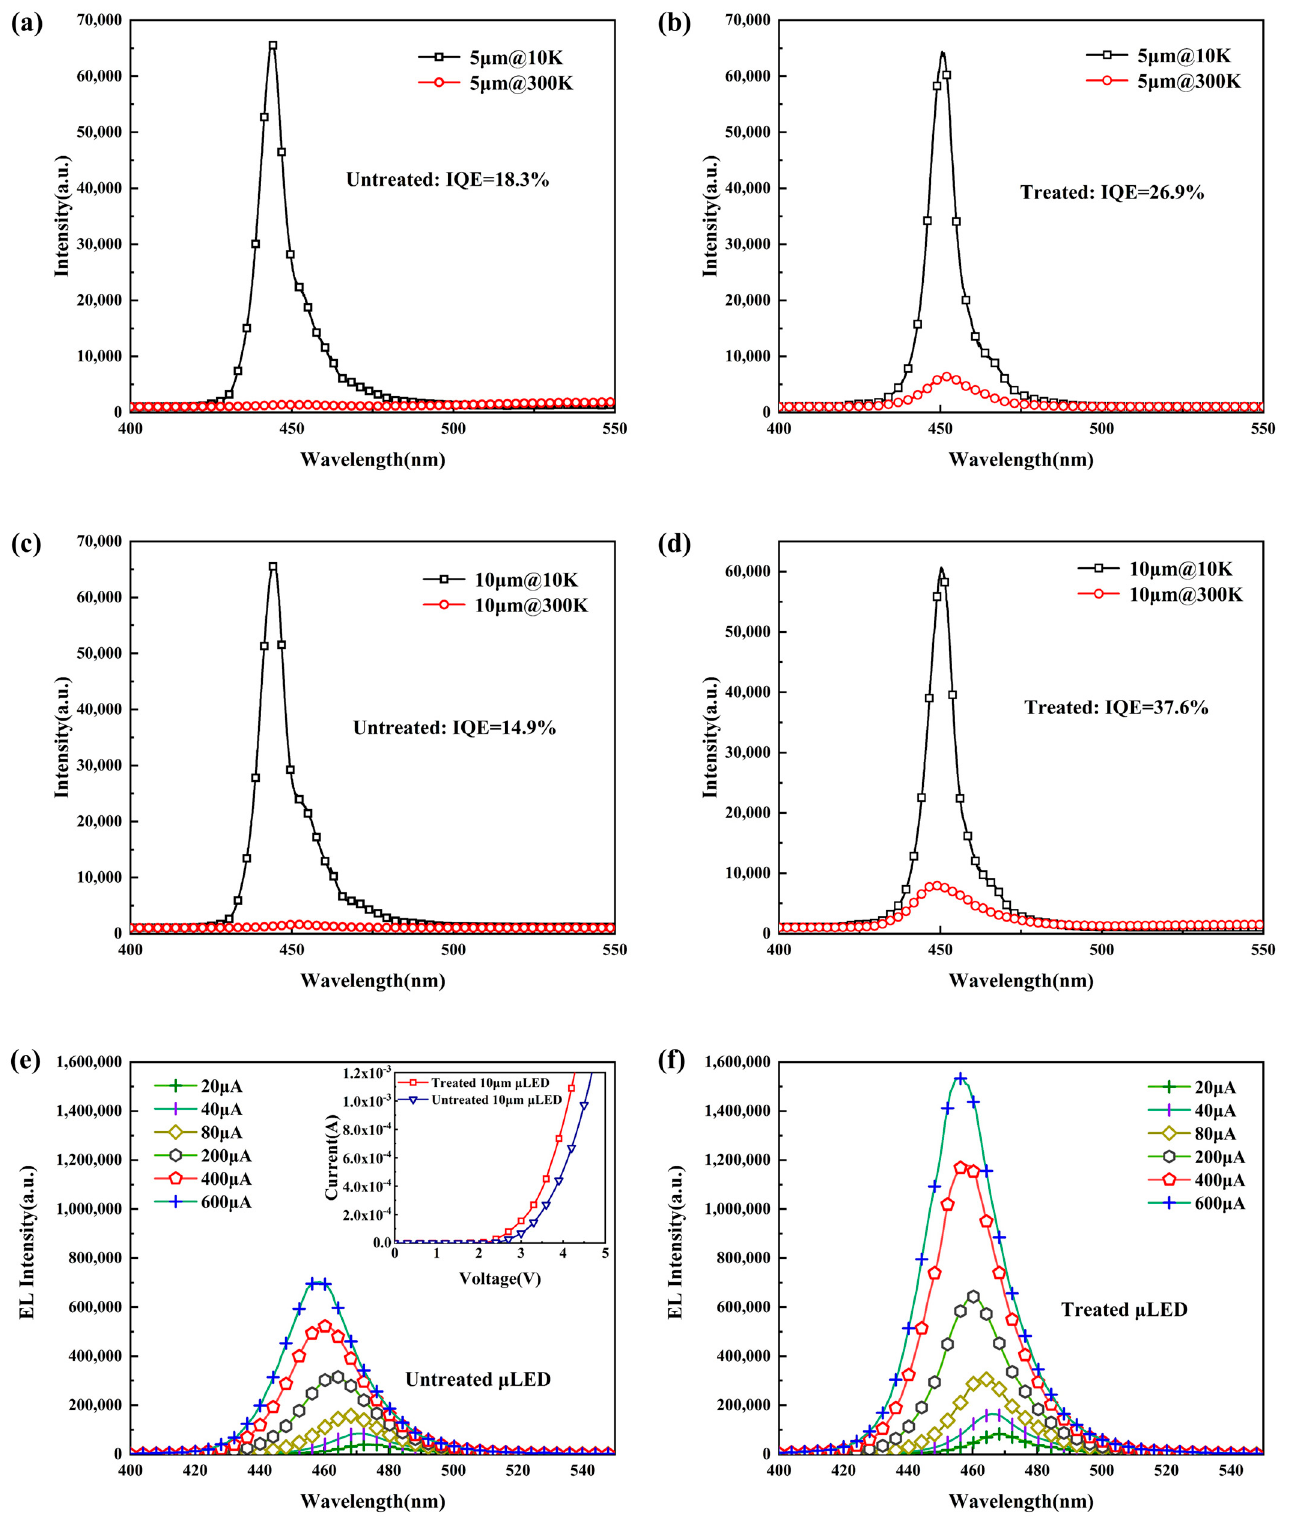
Figure 3. ( a ) TDPL spectra with the corresponding internal quantum efficiency (IQE) values of 5 µ m untreated Micro-LED; ( b ) TDPL spectra with the corresponding IQE of 5 µ m treated Micro-LED; ( c ) TDPL spectra with the corresponding IQE of 10 µ m untreated Micro-LED; ( d ) TDPL spectra with the corresponding IQE of 10 µ m treated Micro-LED; ( e ) electroluminescence (EL) spectra of 10 µ m untreated Micro-LED, and the inset in ( e ) is the current–voltage (IV) curves of 10 µ m Micro-LED before and after passivation; and ( f ) EL spectra of 10 µ m treated Micro-LED.